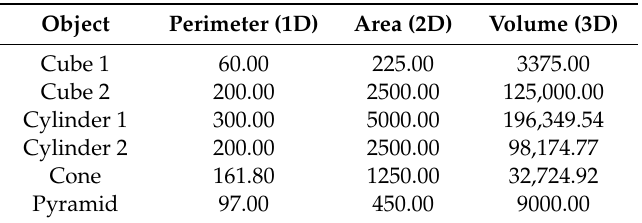
Table 1. Synthetic objects and their 1D, 2D and 3D measurements in cm.